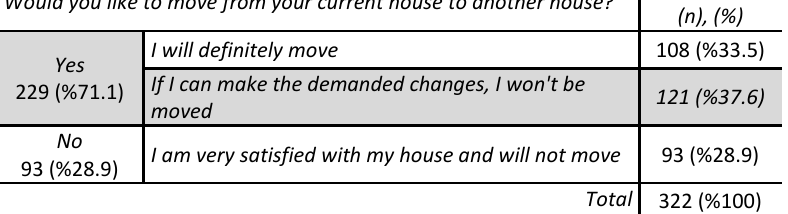
Table 11 Respondents' attitudes about moving regarding the flexibility opportunities Would you like to move from your current house to another